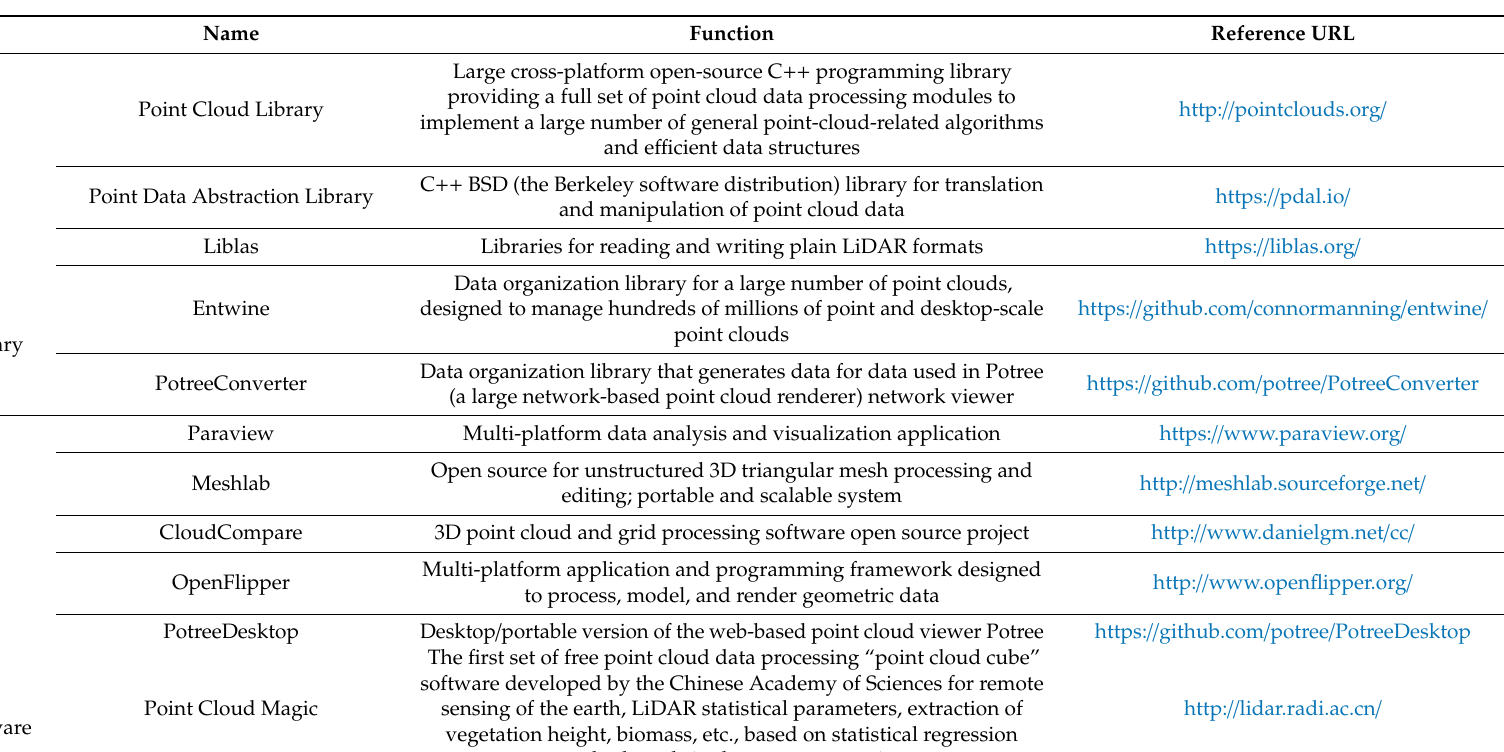
Table 8. Introduction of open source libraries and software for point cloud